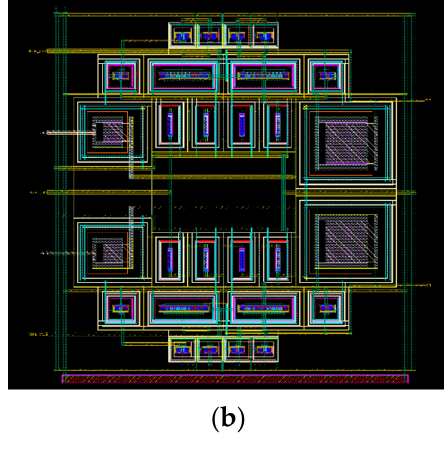
Figure 11. ( a ) LPF schematic [30]. ( b ) Layout of the BPF.